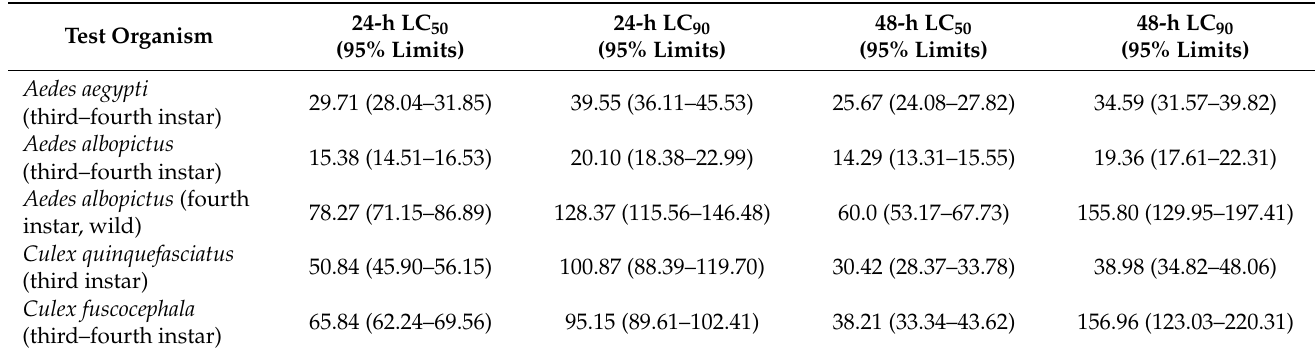
Table 1. Mosquito larvicidal activity of Croton hirtus essential oil ( µ g/mL).